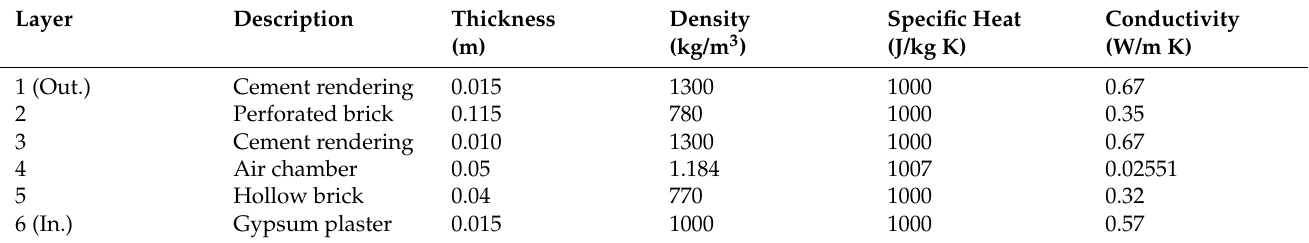
Table 1. Thermophysical properties of the Cell 3 southern wall.